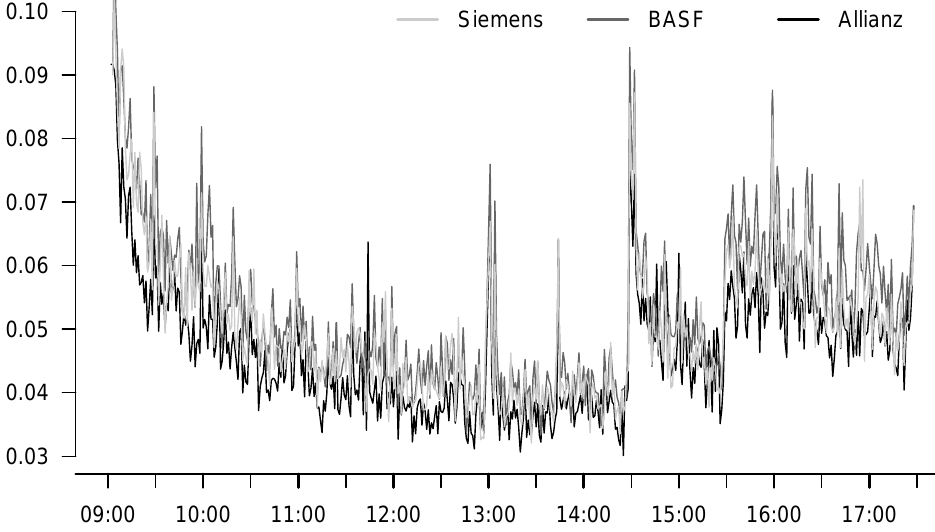
Figure 1. Average realized volatility per one minute of the trading day (in CET) for selected stocks in